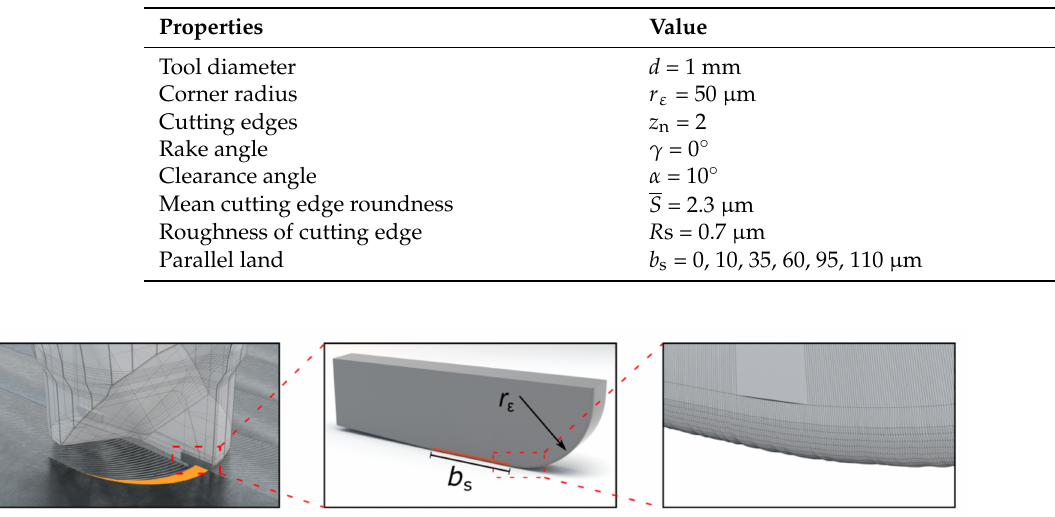
Figure 3. Modeling of the tool design and cutting edge for